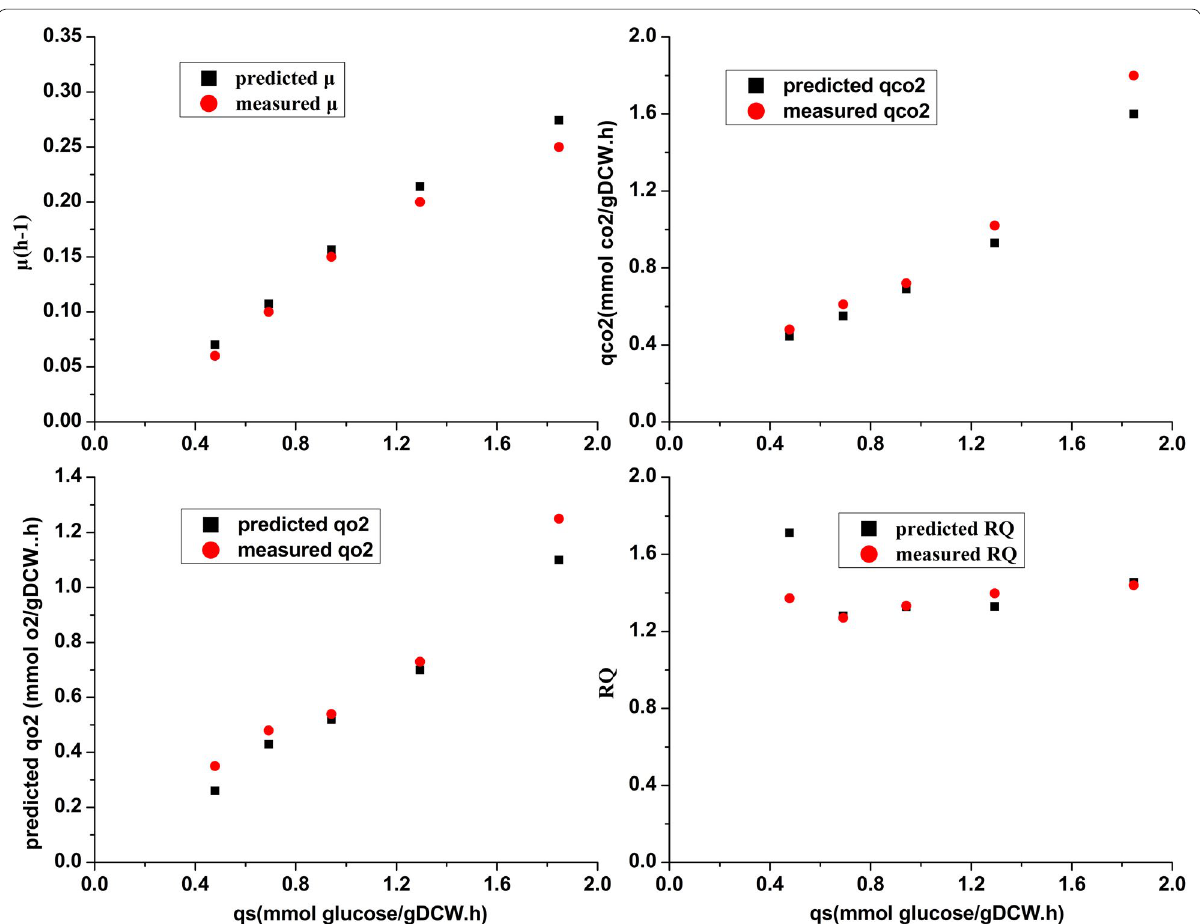
Fig. 4 Predicted and measured μ , qo2, qco2, and RQ for chemostat cultivation of P. pastoris G1HL producing β-galactosidase. Blue represents the GSMM simulated results, and red represents the experimental data